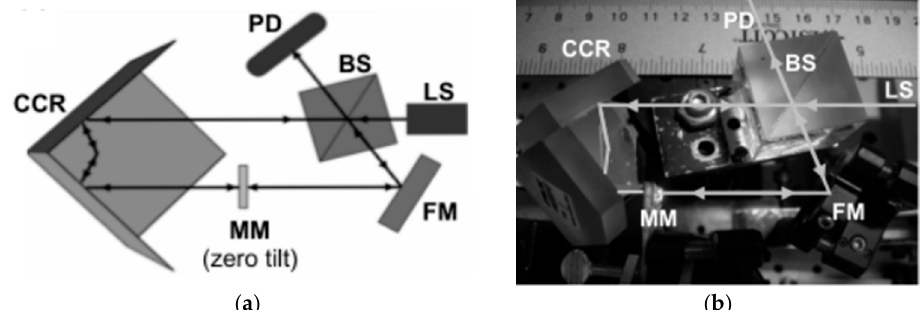
Figure 30. Dual-reflective MEMS mirror-based FTS: ( a ) System Schematic; ( b ) a picture of mirror-tilt-insensitive (MTI)-FTS demonstration setup. CCR: Corner-cube retroreflector. PD: Photodetector. BS: Beam splitter. MM: MEMS micromirror. FM: Fixed mirror. LS: Light source. (Reprinted with permission from Reference [57] IEEE).